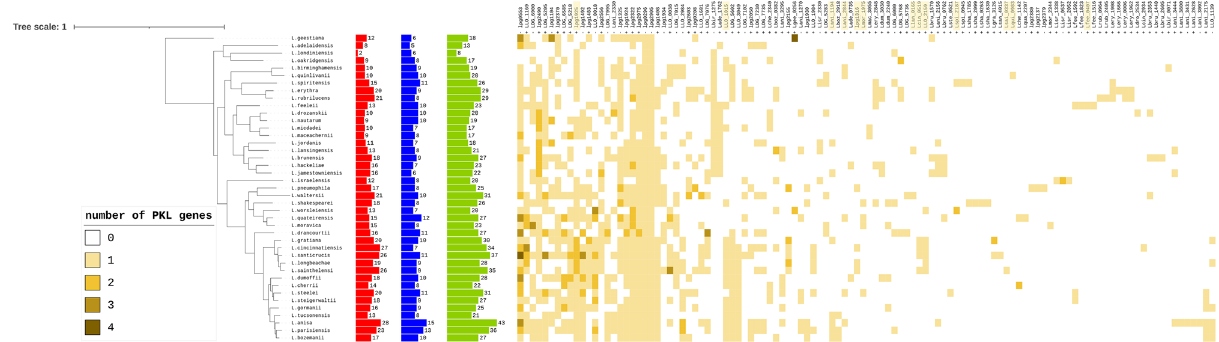
Figure 2. Distribution of 112 kinase LOGs among 41 Legionella species. Histograms on the left: counts of effector kinases shown in red, non-effectors in blue; percentage of effector kinases in a kinome shown in green. Clustered heatmap depicts the numbers of each LOG representative per species (range 0–4). Gene labels marked with plus (+) indicate effector families/LOGs. Novel families are marked by highlighted gene labels. Phylogenetic tree of Legionella species adapted from the publication by Burstein et al. 25,43 .